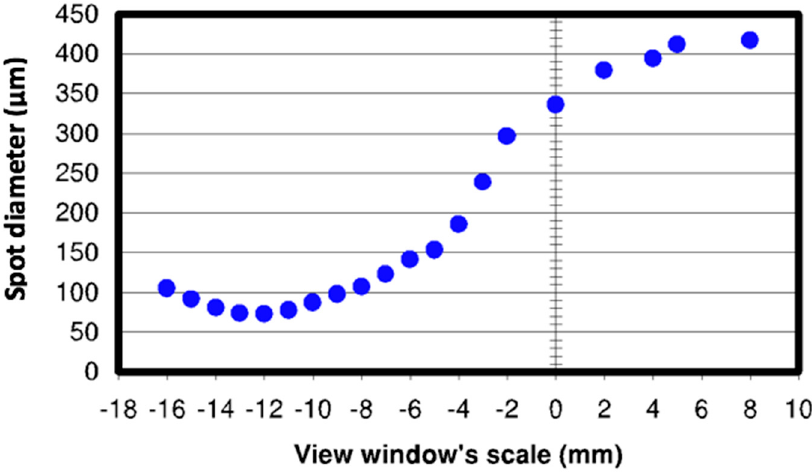
Figure 2. Variation of Ø spot sizes overview window’s scale for Precitec HP1.5” (adapted from Reza [15]).